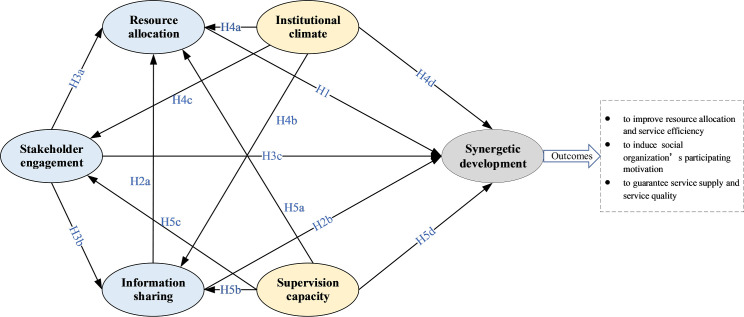
The conceptual framework of synergetic development of social organizations participating in HECS.